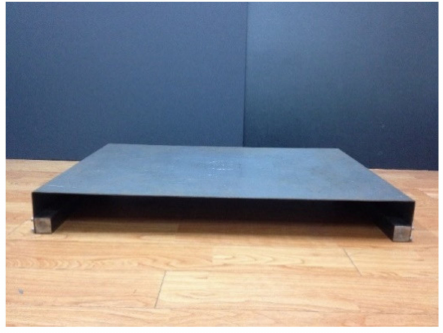
Figure 1. Target